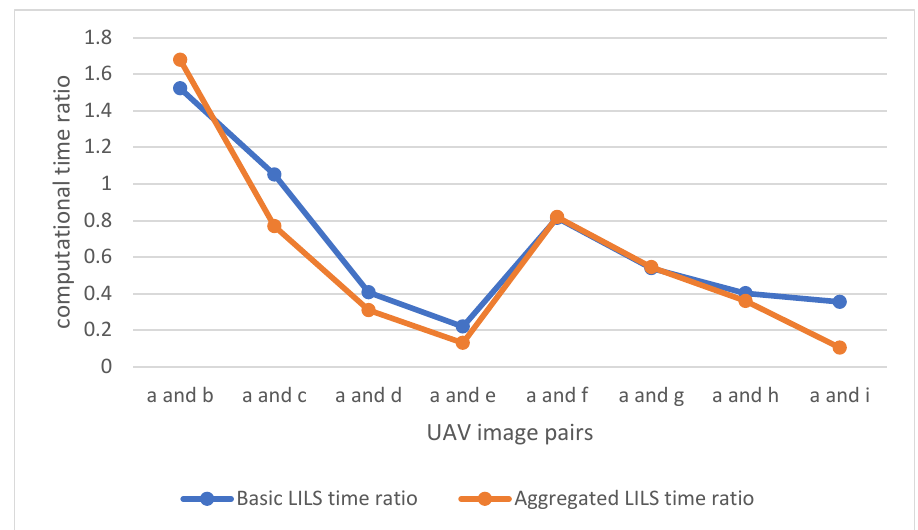
Figure 5. Ratio of computational time with respect to MSAC for the UAV dataset.